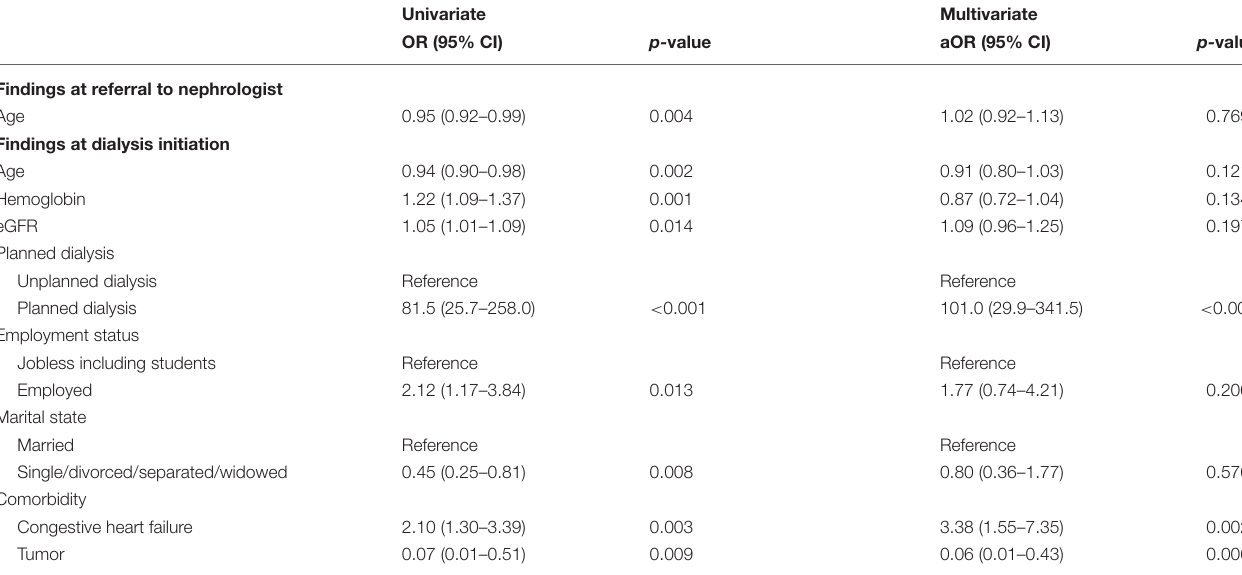
TABLE 5 | Logistic regression analysis of factors associated with selecting peritoneal dialysis in elderly